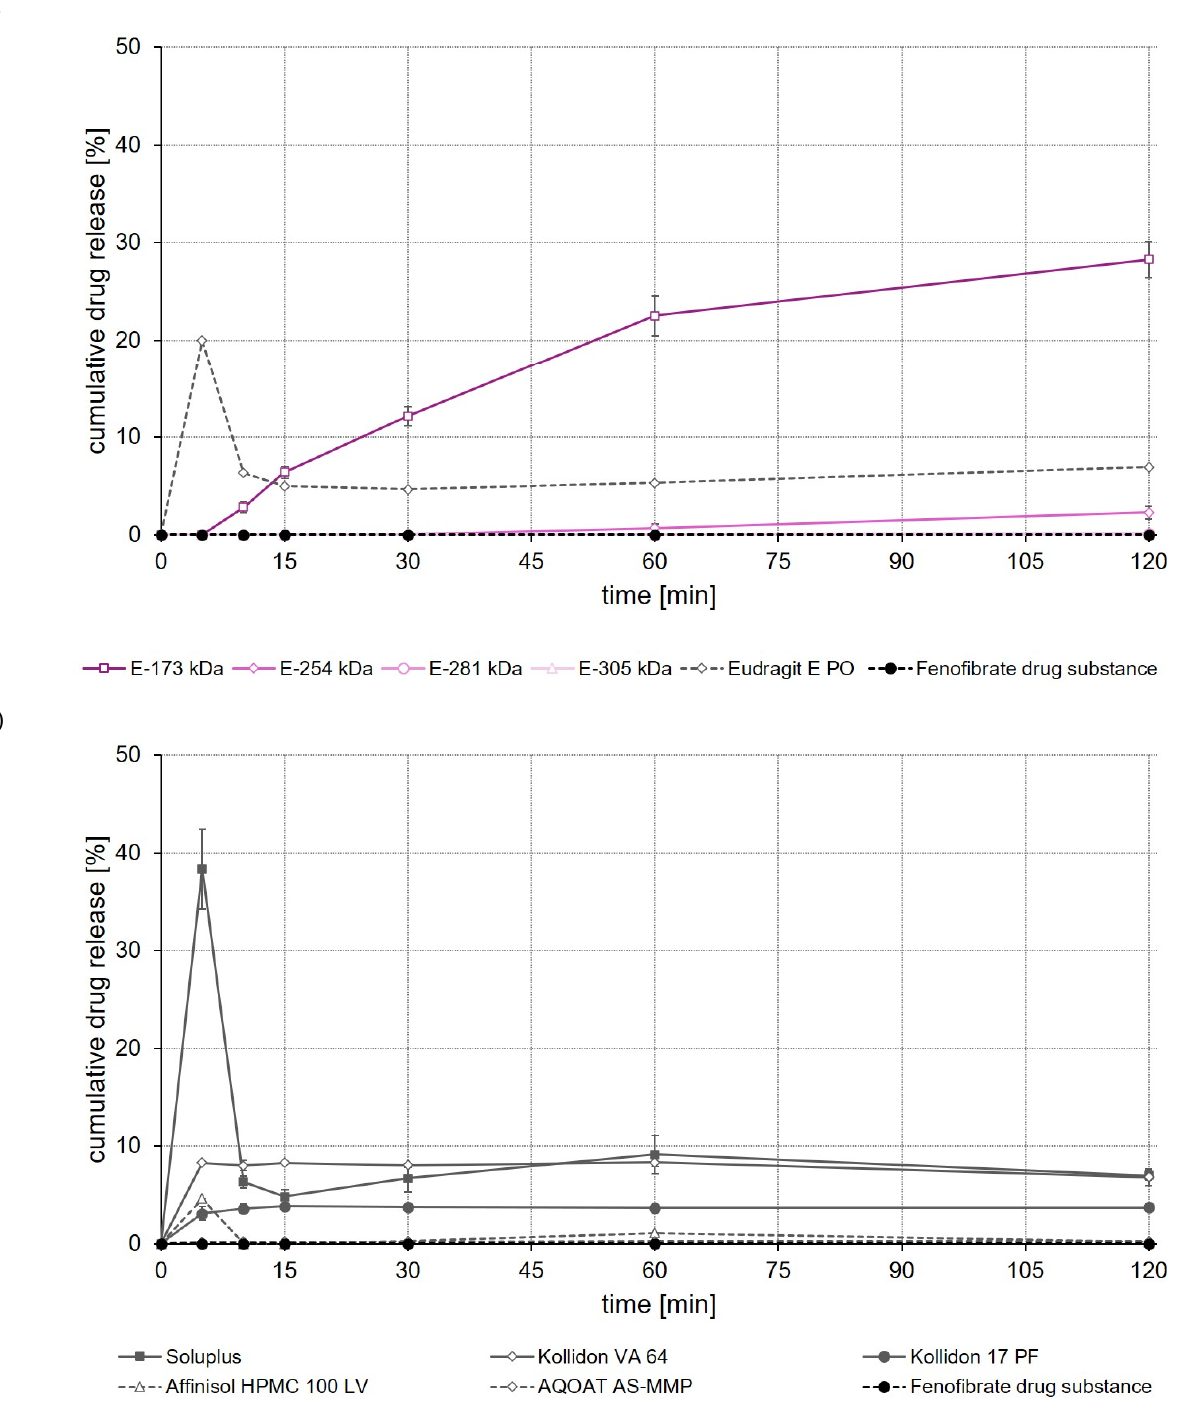
Figure 8. Dissolution profiles of fenofibrate drug substance and fenofibrate ASDs based on ModE and EPO ( a ), as well as fenofibrate drug substance and fenofibrate ASDs based on other marketed (co-)polymers ( b ) in 500 mL 0.1 M HCl in USP apparatus II. Each value designates the mean ± S.D. (n = 3).